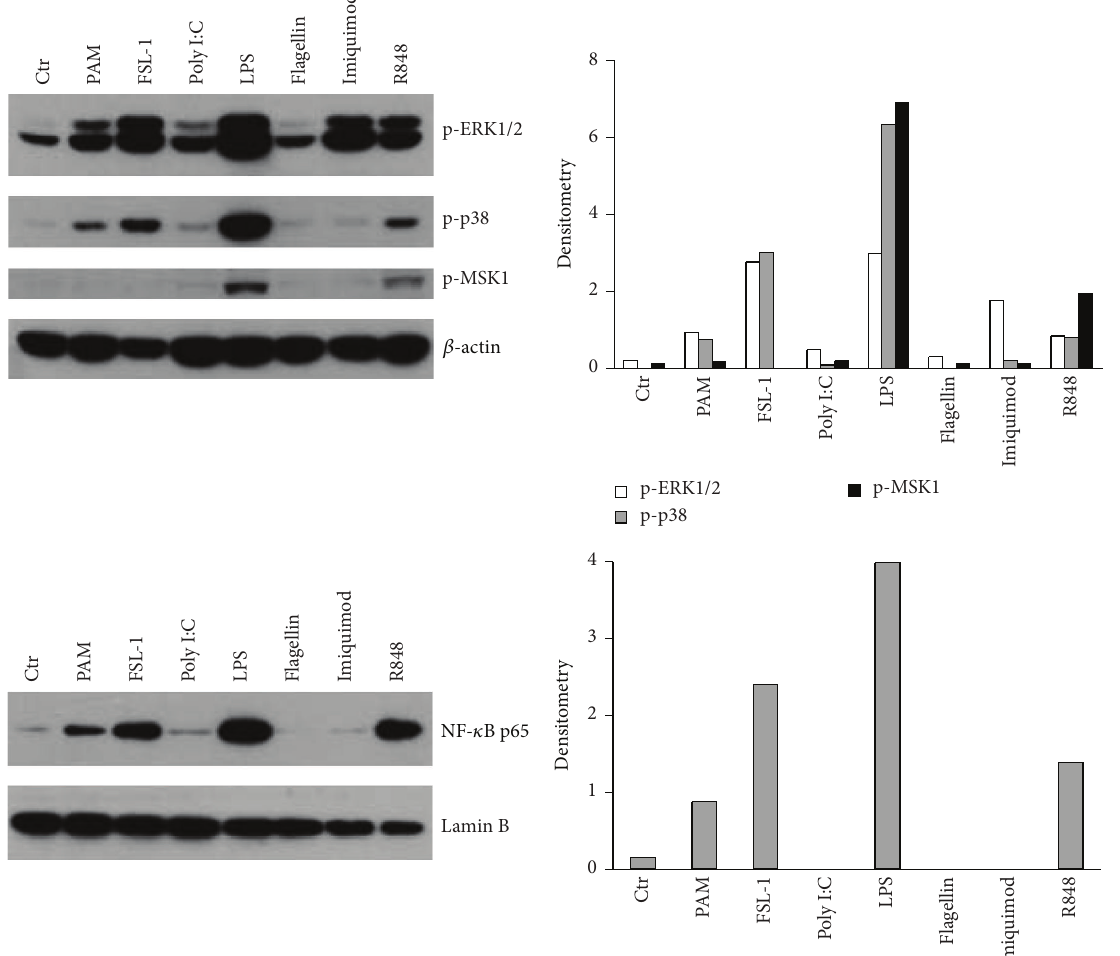
Figure 3: TLRs differentially activate the MAPK and NF- 𝜅 B pathways. DCs were stimulated with TLR agonists as indicated in Figure 1 for 30min. After cell lysis, extracts were blotted against phospho-p38, phospho-ERK1/2, and phospho-MSK1. Nuclear extracts were blotted against NF- 𝜅 B p65. 𝛽 -actin and Lamin B represent loading controls for total and nuclear proteins, respectively. The image depicts results obtained in one representative donor out of